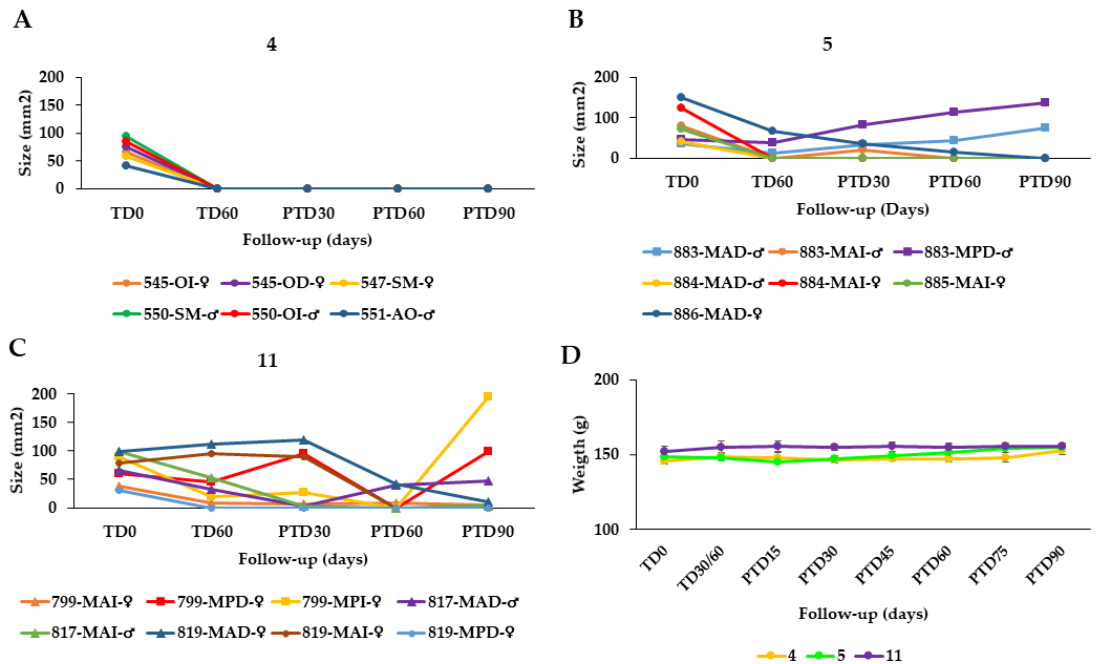
Figure 3. Effect of the topical AT treatment in golden hamsters with cutaneous leishmaniasis caused by Leishmania tropica . The figure shows the development of the lesion size in each hamster during the study in mm 2 measured at various time points (graphics ( A , B )). Disease progression was monitored before treatment administration (TD0), at the end of treatment (TD60) and on days 30, 60 and 90 post-treatment (PTD30, PTD60 and PTD90, respectively). ( A ): Group Group 4 ; L. tropica , 19.2 μg total STL, 2x day, 60 days; ( B ): Group 5 ; L. tropica , 38.4 μg total STL, 2 × day, 60 days; ( C ): Group 11 ; hamsters infected with L. tropica treated with meglumine antimoniate (MA), 200 μ g/1× every 3 d, 30 d. Cure ( • ); improvement ( (cid:78) ); and failure ( (cid:4) ). The series in each panel correspond to the code of each hamster. ( D ) : Development of the animals’ body weight of hamsters infected with L. tropica during the study. Changes in the body weight were monitored before treatment administration, at the end of treatment, and every two weeks until the study ended. TD0: Before treatment; TD30 for MA or TD60 for Arnica formulations: last day of treatment administration; PTD15: 15 days after the treatment ends; PTD30: 30 days after the treatment ends; PT45: 45 days after the treatment ends; PTD160: 60 days after the treatment ends; PTD75: 75 days after the treatment ends; and PTD90: 90 days after the